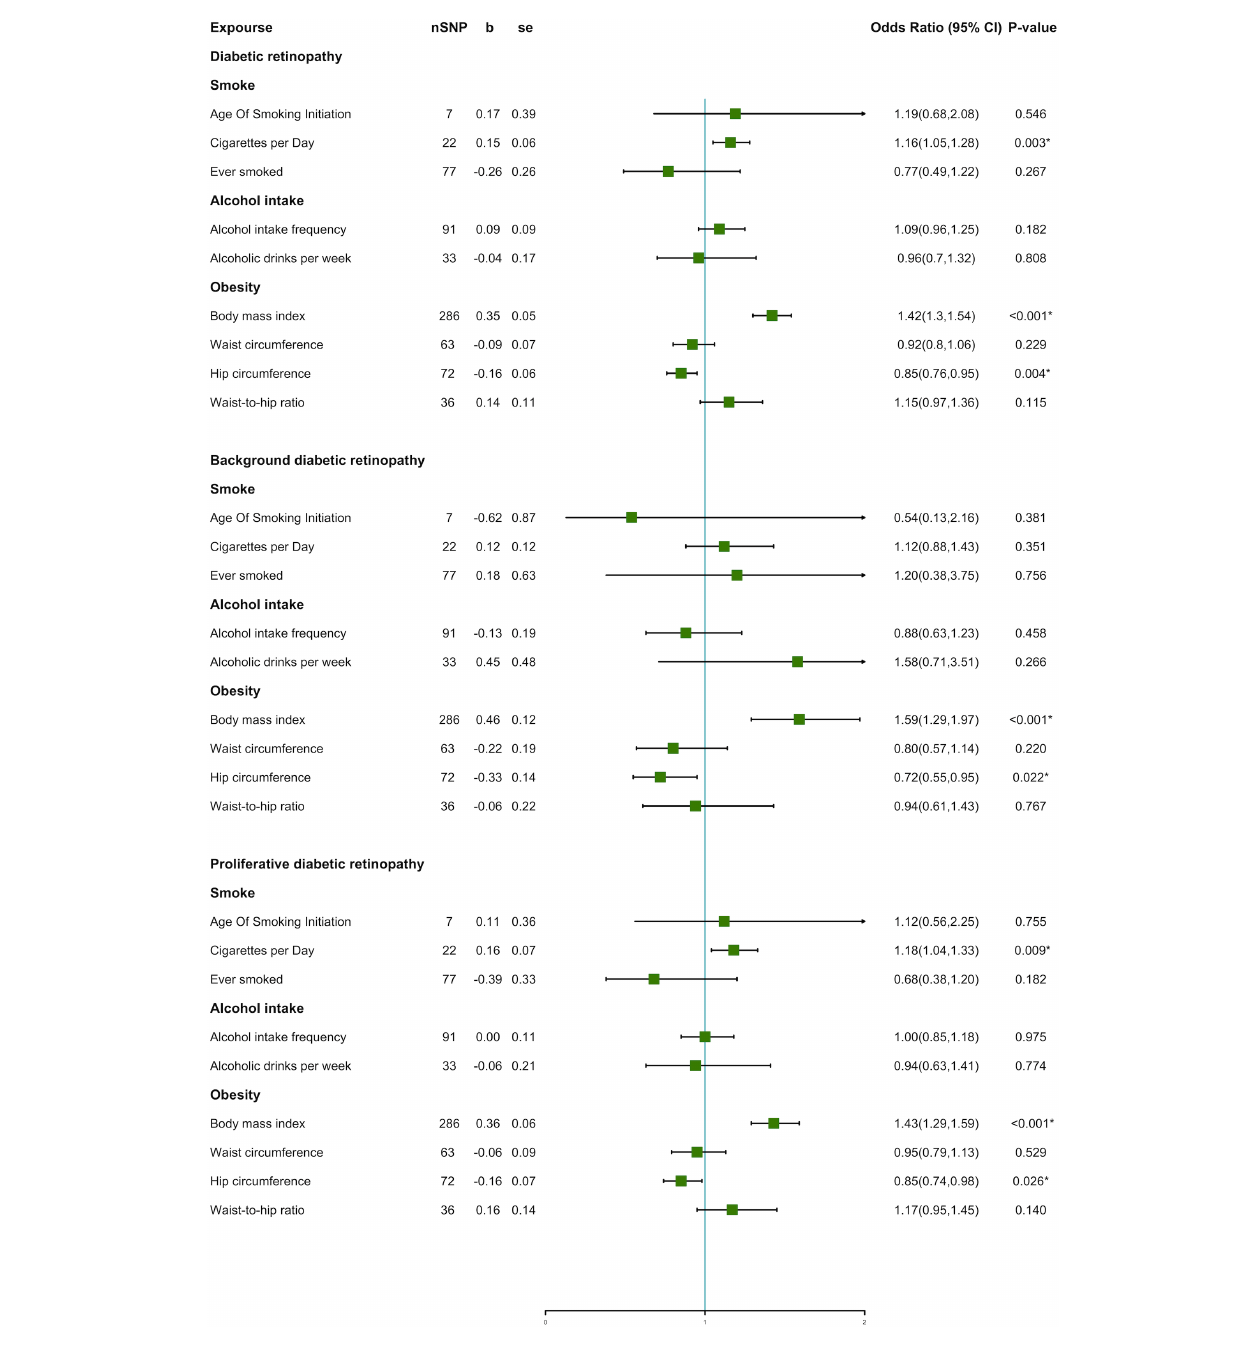
FIGURE 4 Forest plot of unhealthy lifestyle factors associated with the risk of DR and its